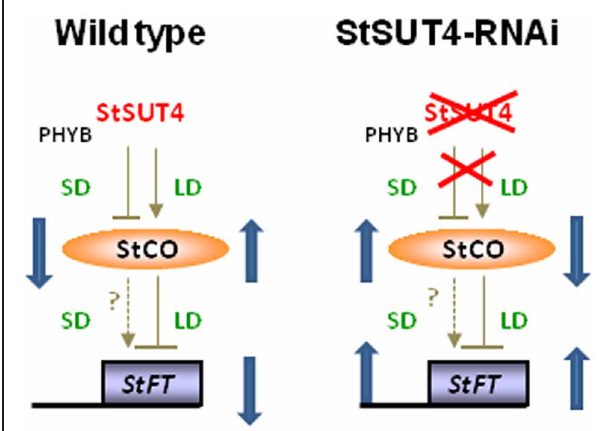
FIGURE 6 | Hypothetical model illustrating the assumed impact of the circadian-regulated gene StSUT4 on the photoperiod-dependent accumulation of StCONSTANS (StCO) and flowering locus T (StFT) transcript levels. Whereas in WT plants StSUT4 inhibits StFT accumulation under long day conditions, this photoperiod-dependent regulation via the StCONSTANS protein is deregulated in StSUT4 -inhibited plants leading to increased StFT levels under both, long day and short day conditions leading to early flowering and tuberization even under non-inductive